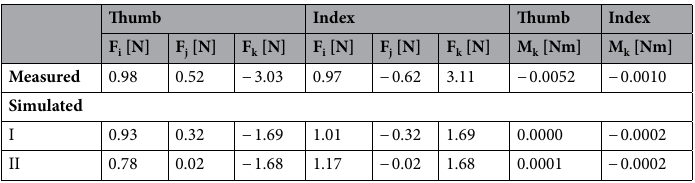
Table 3. Comparisons of measured and simulated forces and moments of free pinch.